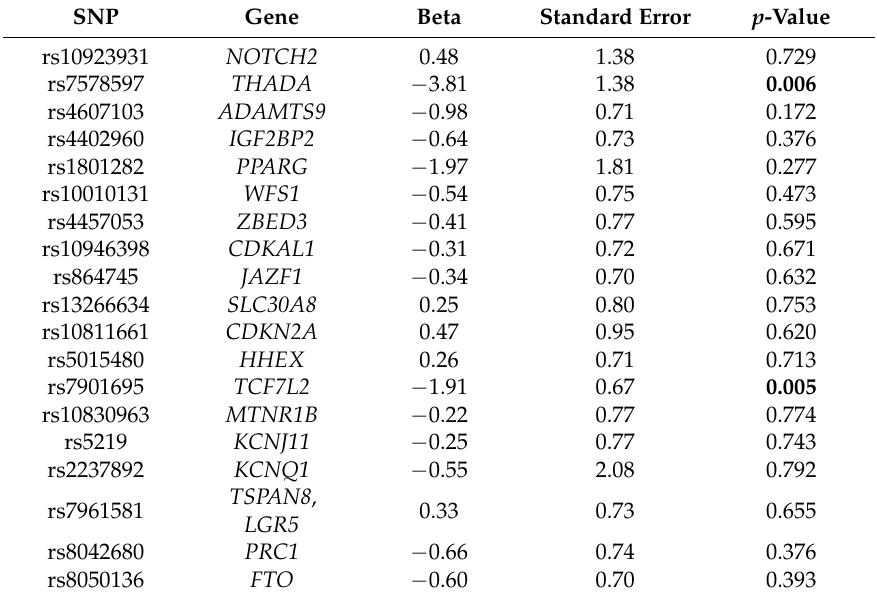
Table 3. Results for single SNP association analyses with the age at T2D first